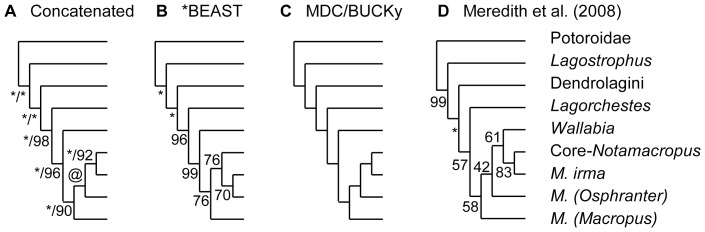
Macropodid species tree estimates from the combined mitochondrial and nuclear sequences (MtNuc16).(A) concatenated sequences, showing BPP/BPML (@ = 0.89/59), (B) *BEAST partitioned between the mtDNA and five nuclear genes, showing BPP values. (C) both MDC and BUCKy, which recovered the same tree from the mt and five nuclear gene trees. (D) Meredith et al. (2008) with BPML values included for comparison. Several supraspecific clades that were identical across all reconstructions were collapsed for visualization convenience. Relationships within each of the collapsed clades were as inferred in Figure 2. Asterisks indicate full BPP or BPML support.